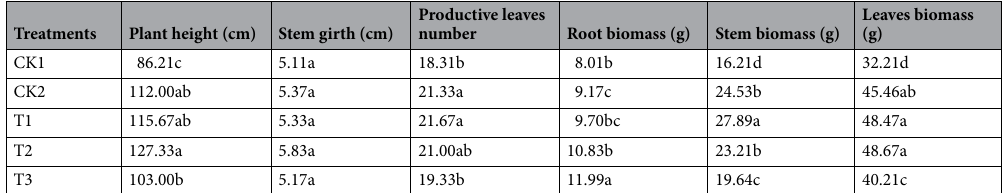
Table 1. Effect of straw biochar application on the agronomic traits and biomass of tobacco at mature stage. Different letters in each column indicate significant differences ( p < 0.05) among the treatments for each parameter.